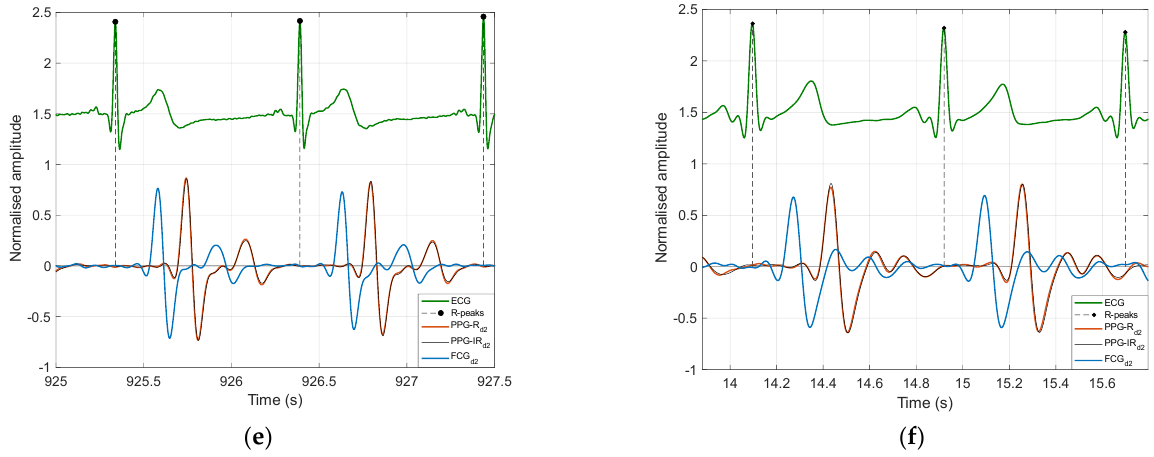
Figure 4. Comparison of PW signals and related first and second derivatives, acquired by the PPG sensor (red and infrared photodetectors) and the piezoelectric FCG sensor, along with the concurrently acquired ECG lead I. Signals acquired in subjects #1 and #3 are depicted in the first and second columns, respectively. The original PW signal, first derivative, and second derivative of both subjects are depicted in the first ( a ),( b ), second ( c ),( d ), and third ( e ),( f ) rows, respectively.